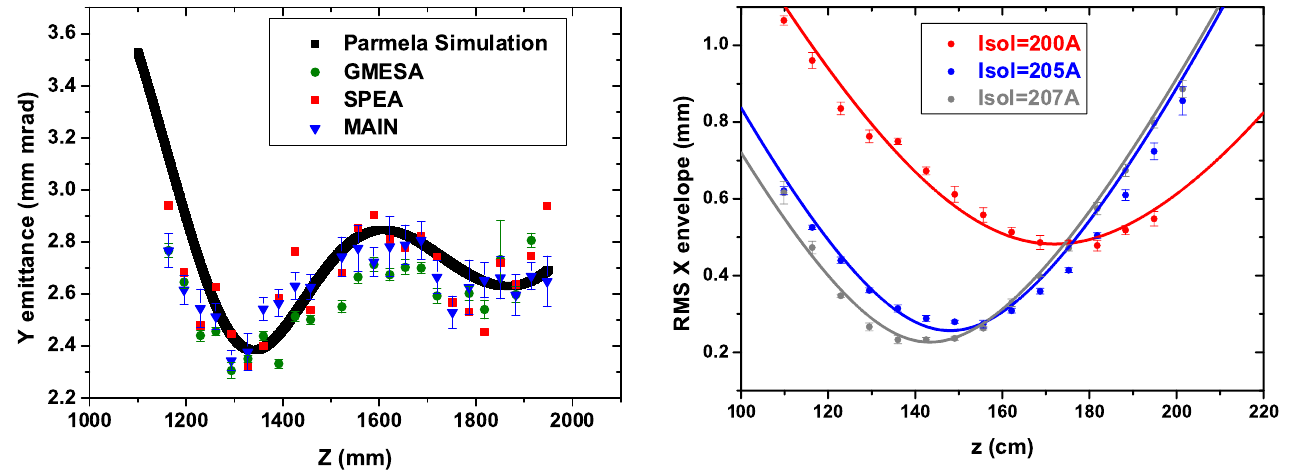
FIG. 9. (Color) An example of rms envelope measurement along the beam line for different solenoid currents. The solid lines are PARMELA